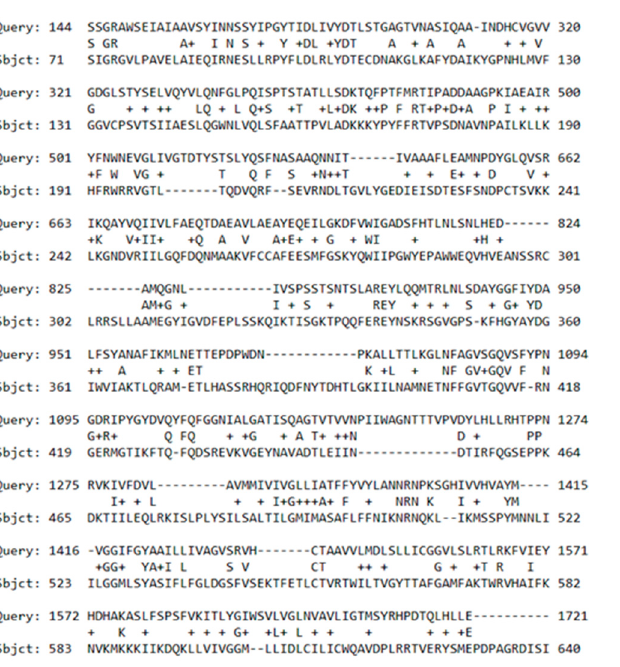
Table 1. Comparison of GABA receptor transcripts.